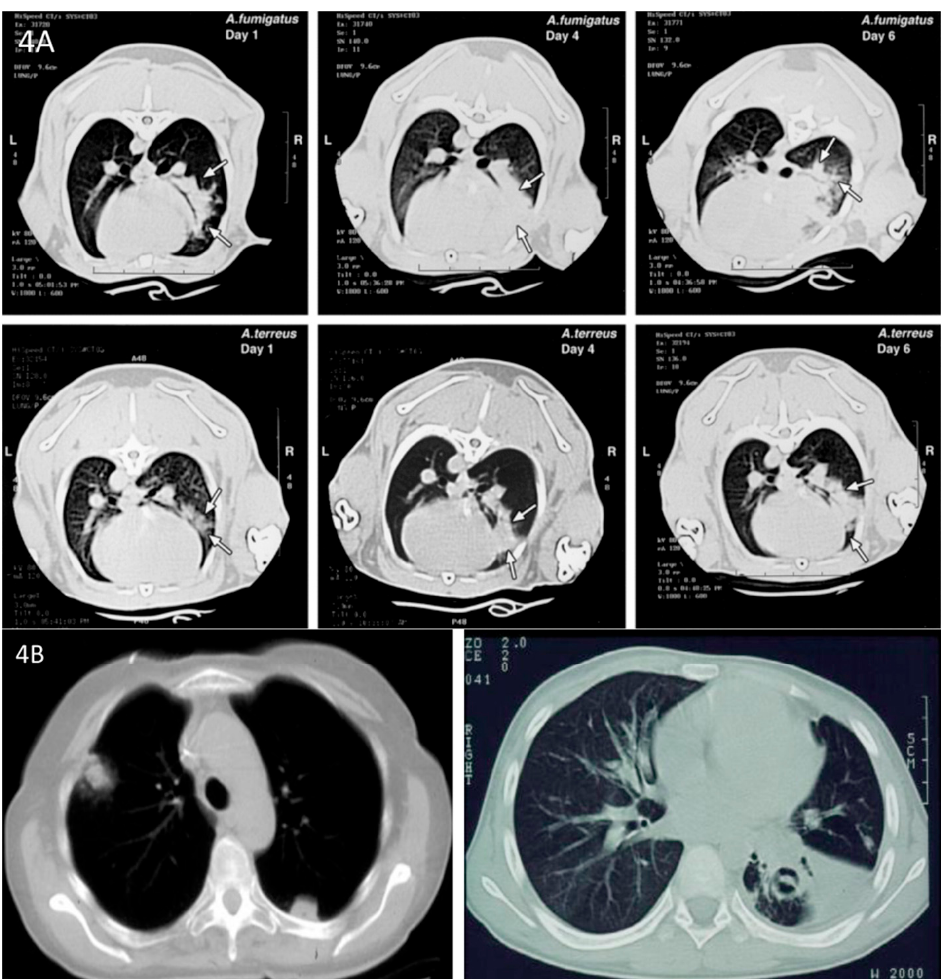
Figure 4. ( A ) . Computed tomography (CT) scan of the rabbit thorax with invasive pulmonary aspergillosis demonstrates segmental and nodular infiltrates with halo signs on days 1, 4, and 6 post inoculation. ( B ). Chest CT scans of patient with invasive pulmonary aspergillosis caused by A. fumigatus reveals nodular infiltrates with halo sign (left panel) and wedge-shaped segmental infiltrate with crescent sign (right panel).